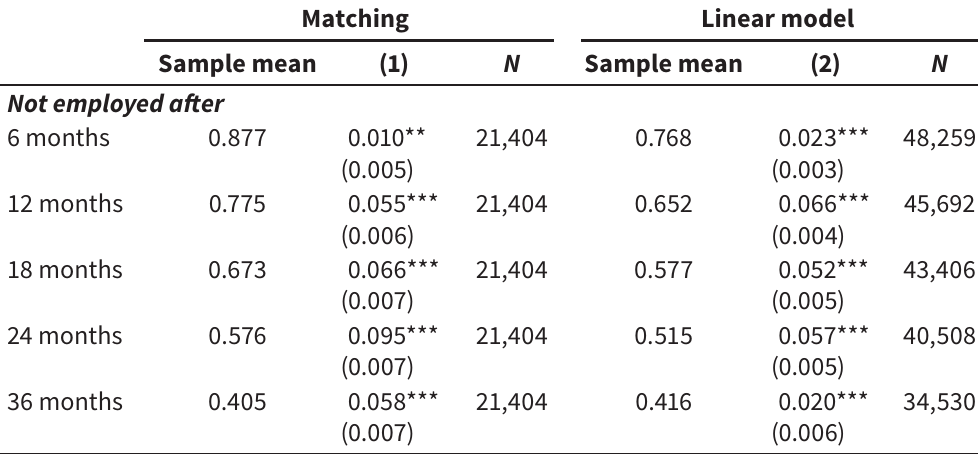
Nearest neighbor matching and linear model